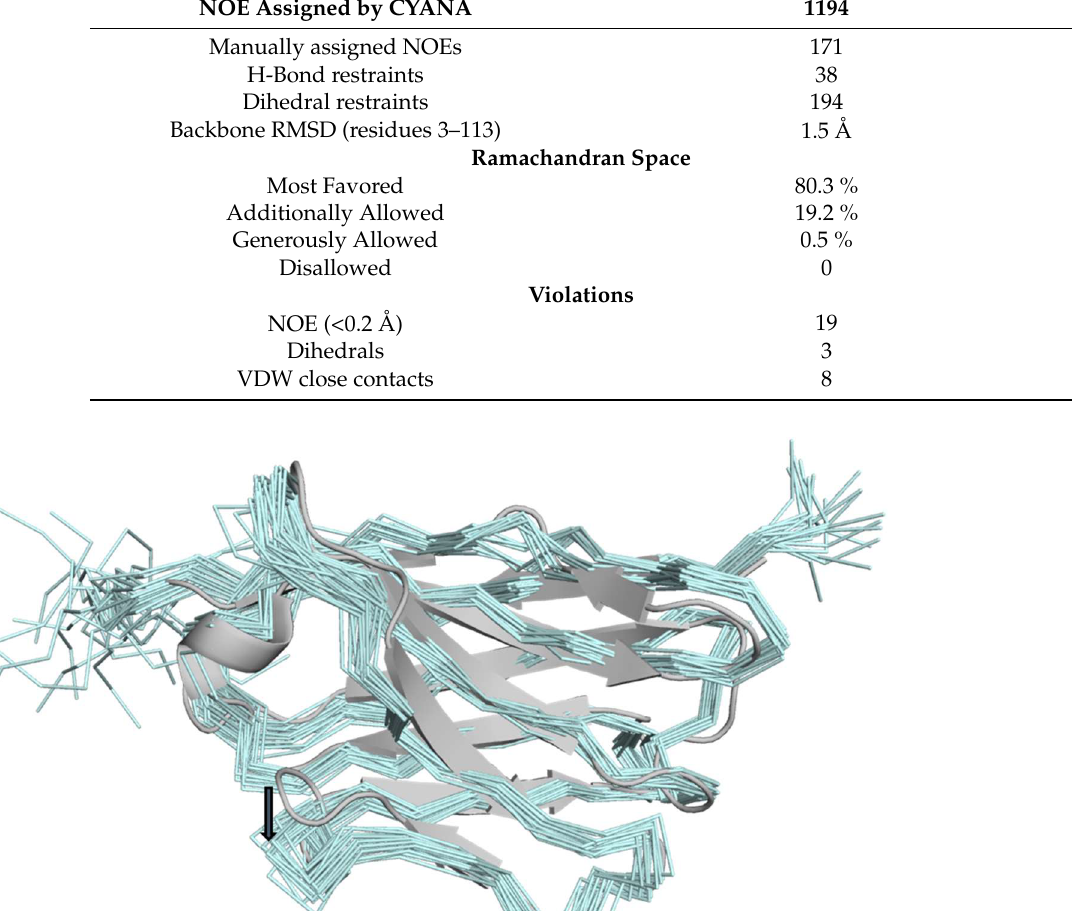
Table 1. Summary of restraints used for NMR structure determination and structure refinement statistics (20 structures) of experimental restraints.